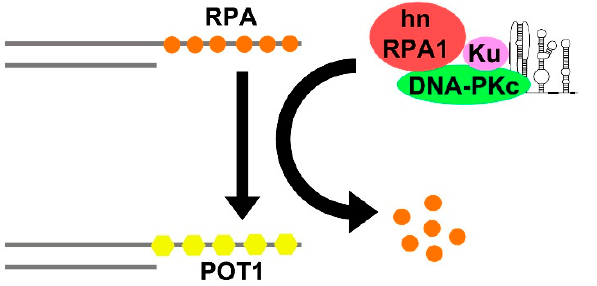
Figure 4. TERC collaborates in telomeric RPA to POT1 switch. TERC and DNA-PK (Ku + DNA-PKc) phosphorylate hnRNPA1; the latter removes RPA from telomeres, causing its substitution with POT1 and allowing telomere capping.